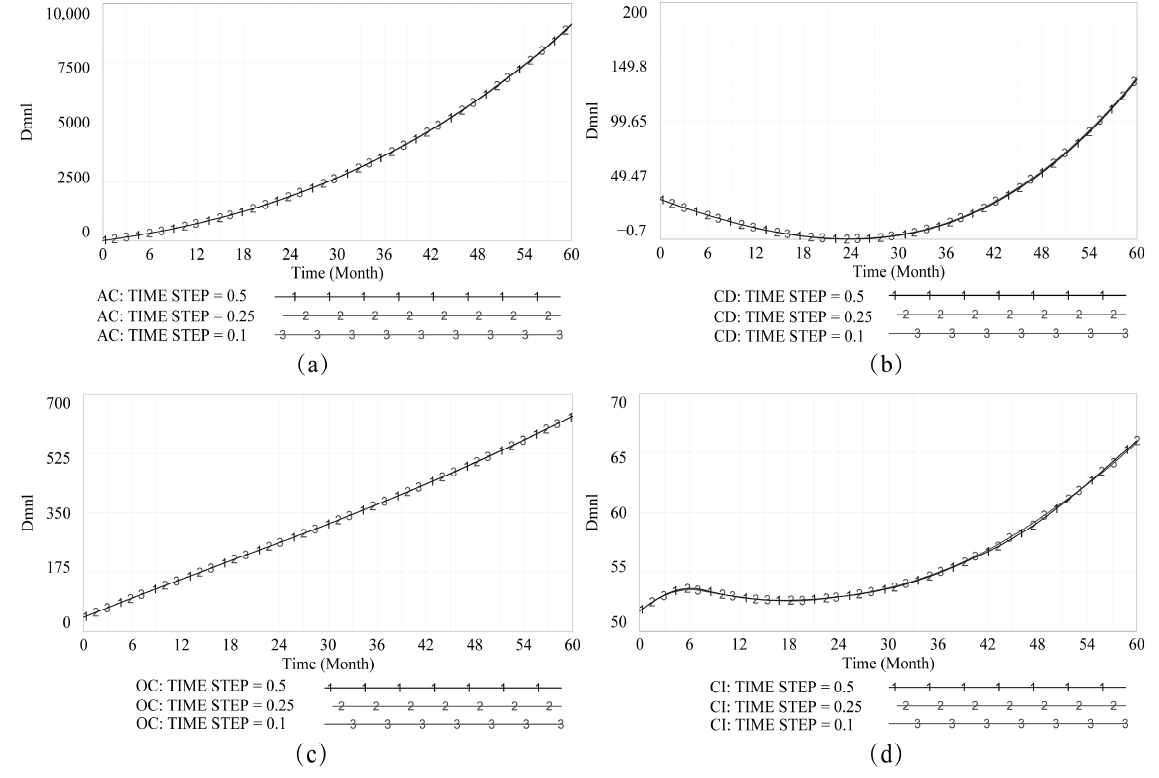
Figure 3. Integral error test of the model. Subfigures ( a – d ) illustrate the AC, CD, OC, and CI curves under varied time steps.